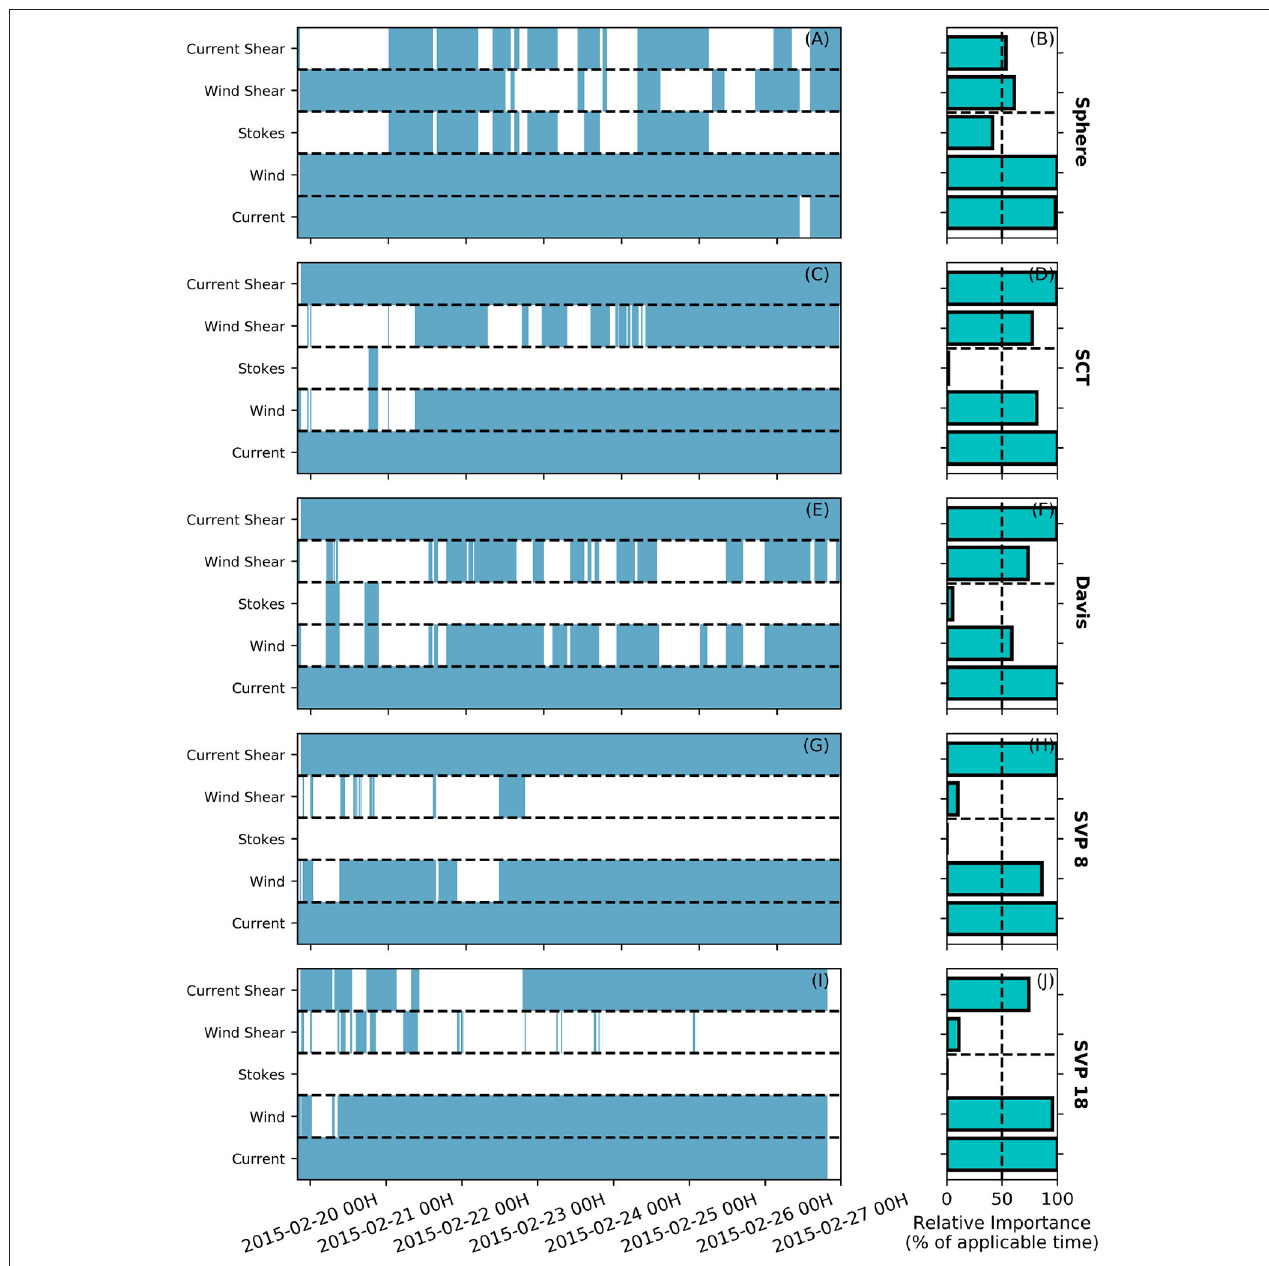
FIGURE 7 | Summary of optimal forcing terms for each drifter as a function of time. In the left-hand (A,C,E,G,I) , timesteps where a forcing term contributed to the solution achieving the highest skill score are shaded in blue for each drifter type. In the right hand (B,D,F,H,J) the percentage of applicable time each forcing term contributed to the optimal solution is